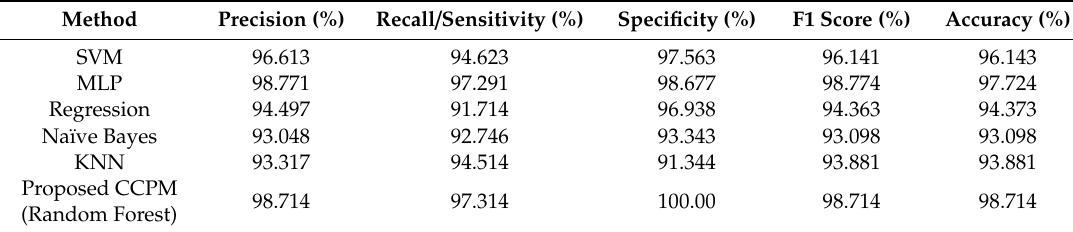
Table 12. Performance evaluation results based on iForest and SMOTE for Schiller.